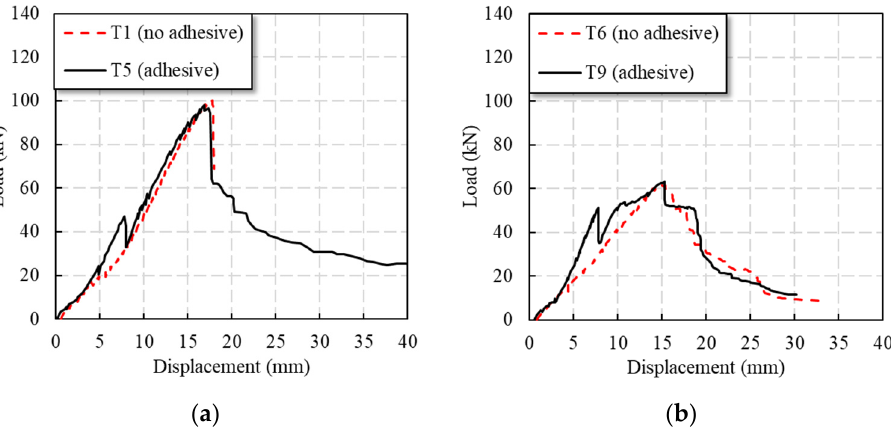
Figure 10. Load–displacement curves for comparison of the bolted and bolted–bonded hybrid connection: ( a ) thick plate, and ( b ) thin plate .